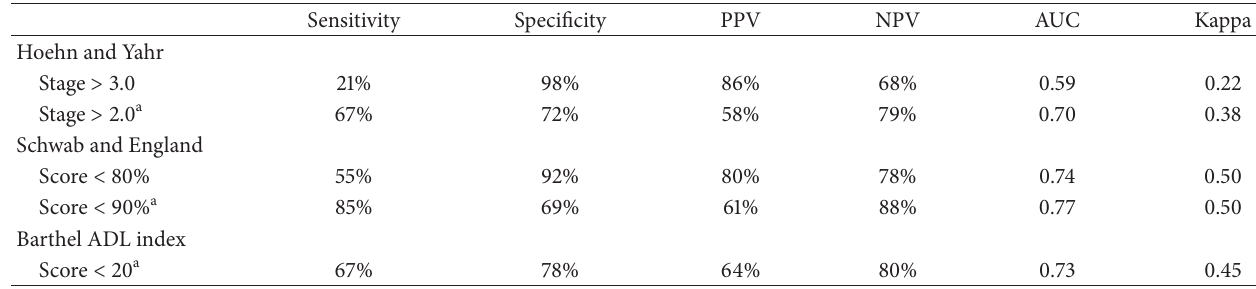
Table 2: Reliability of the Hoehn and Yahr stage, Schwab and England scale, and Barthel ADL index in the detection of loss of independence in PD compared to clinical interview.